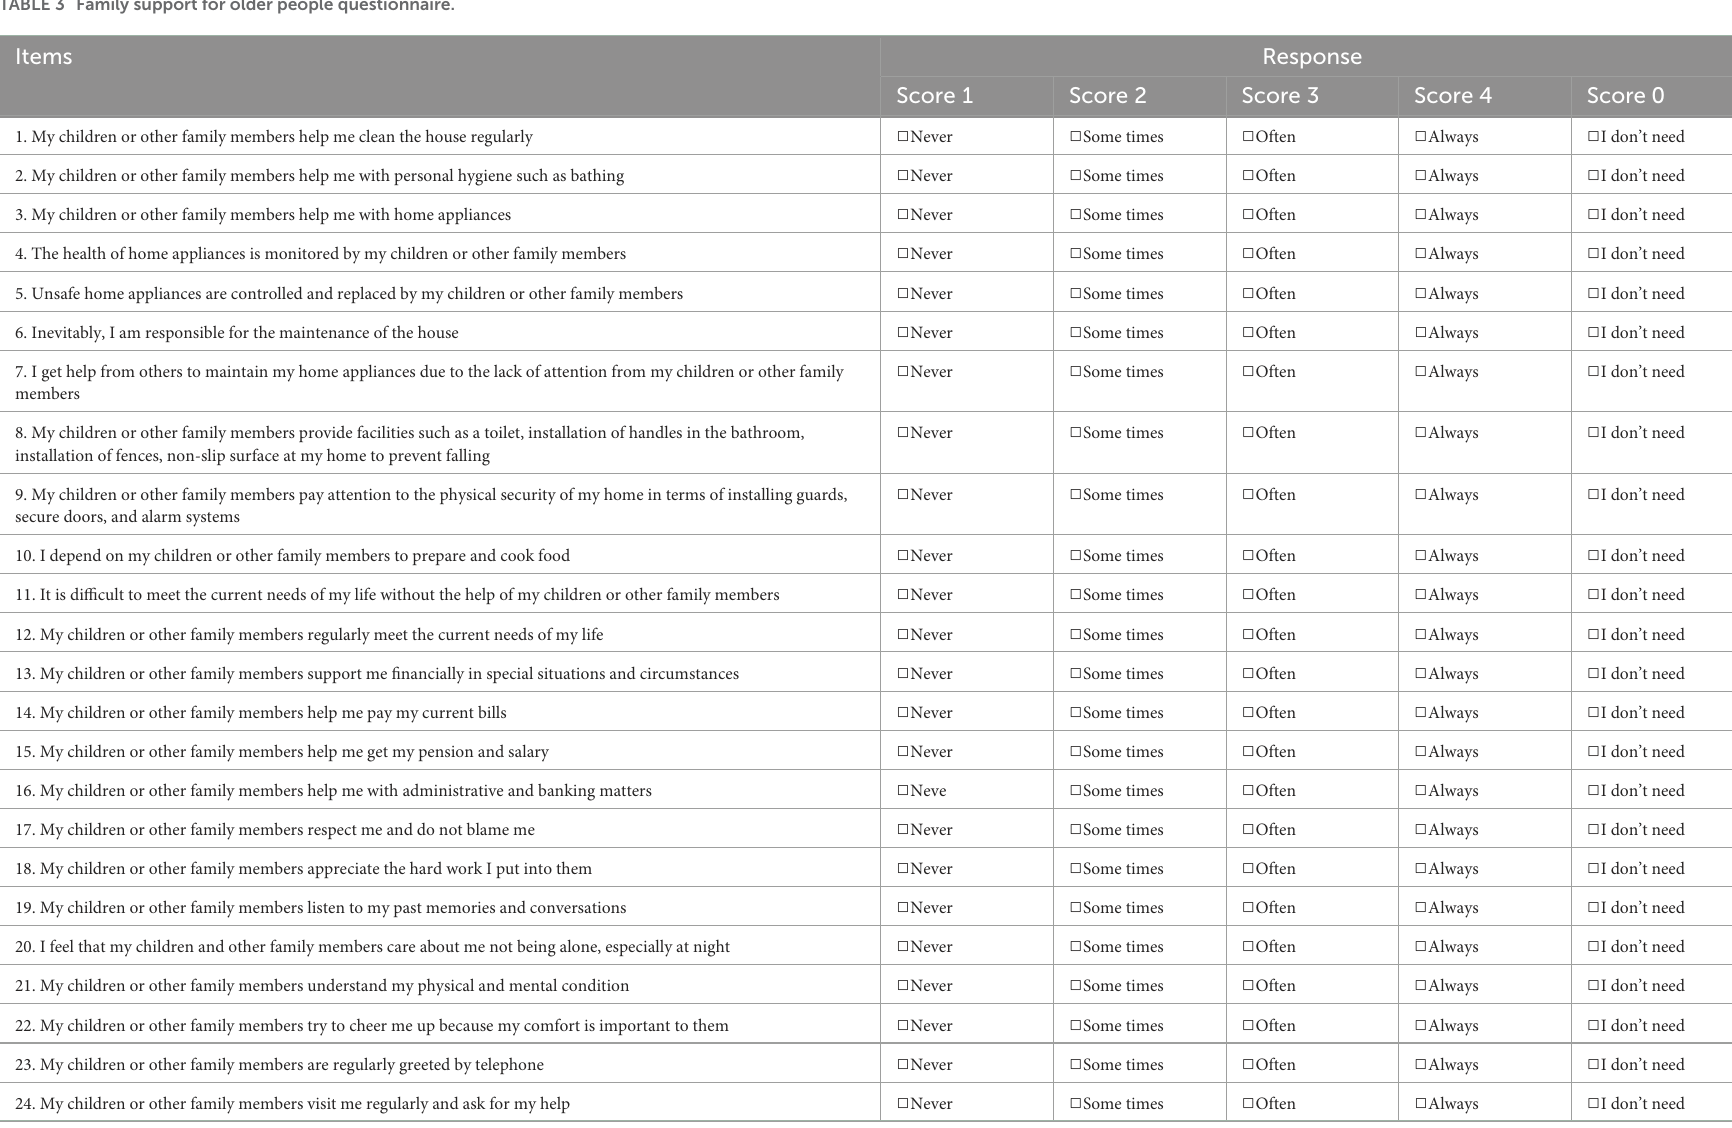
TABLE 3 Family support for older people